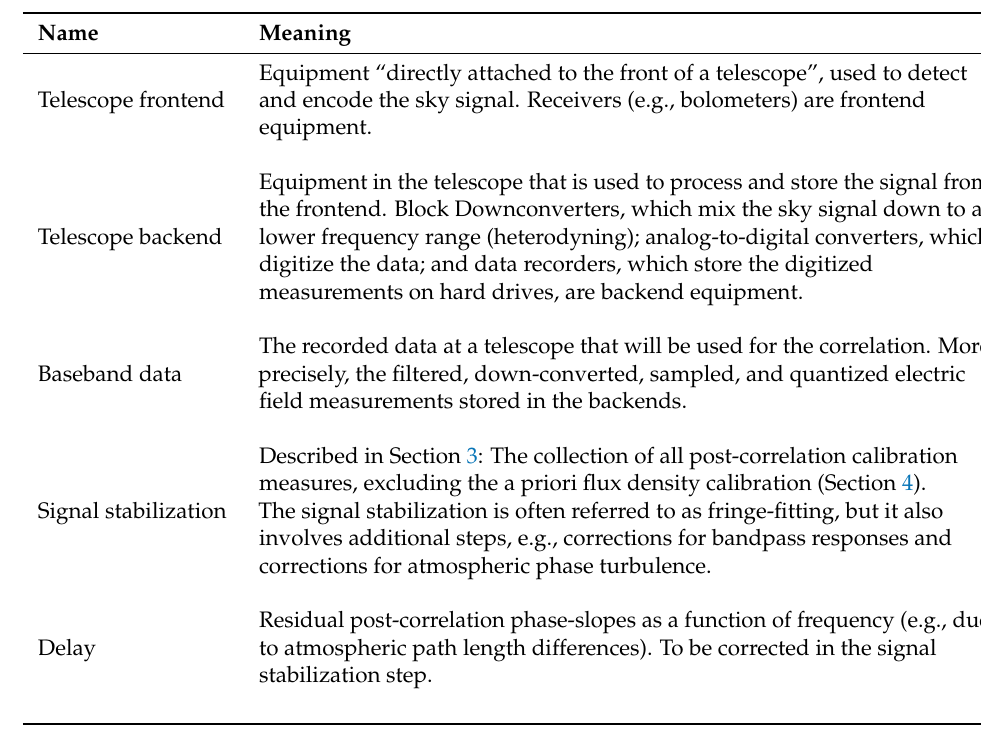
Table 1. Basic terms, definitions, and concepts are listed here, which new VLBI users might be unfamiliar with or which might have slightly different meanings in other related